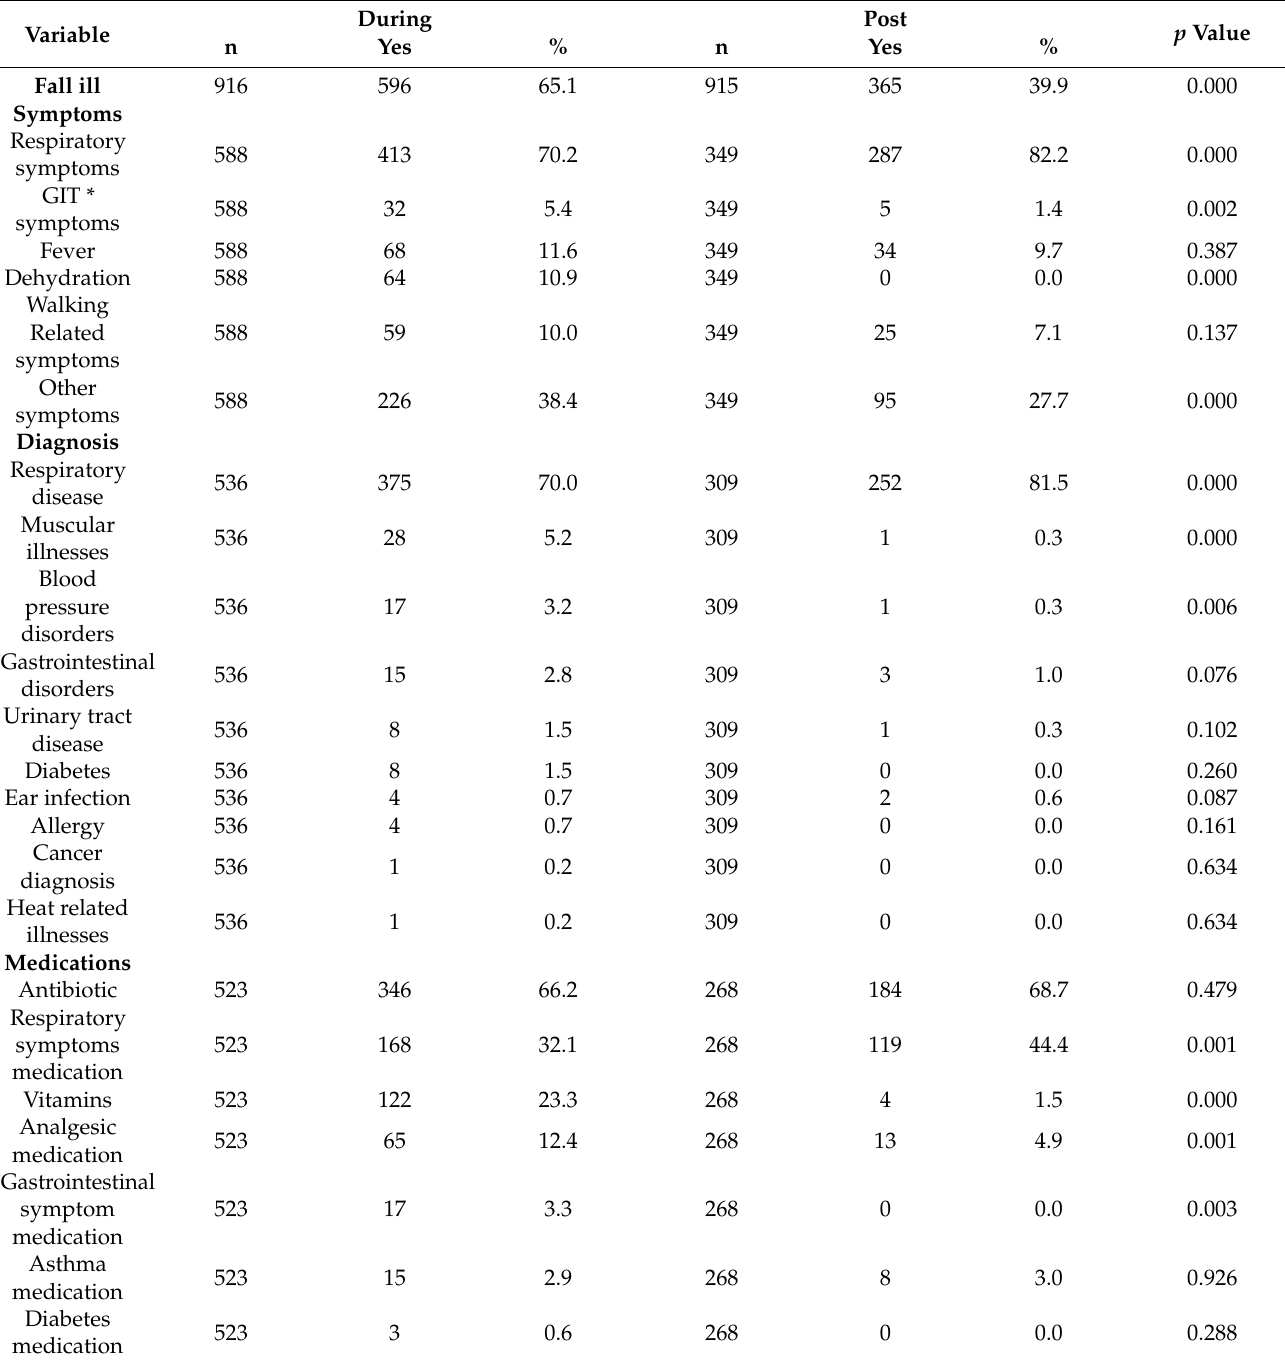
Table 4. Health issues during and